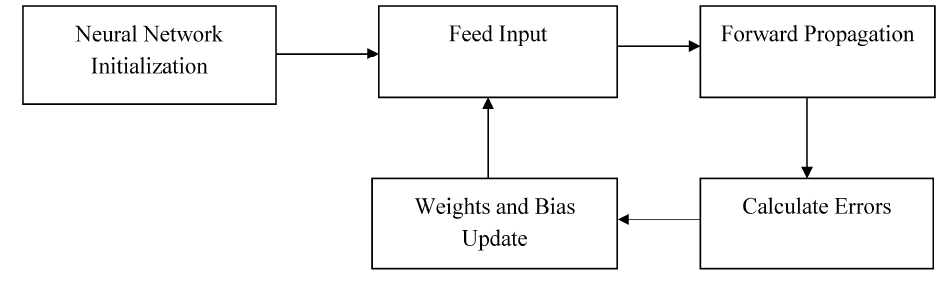
Figure 1. Training of the neural